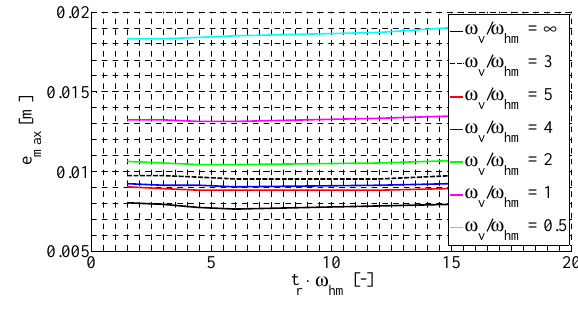
Figure 10: Maximum error during the